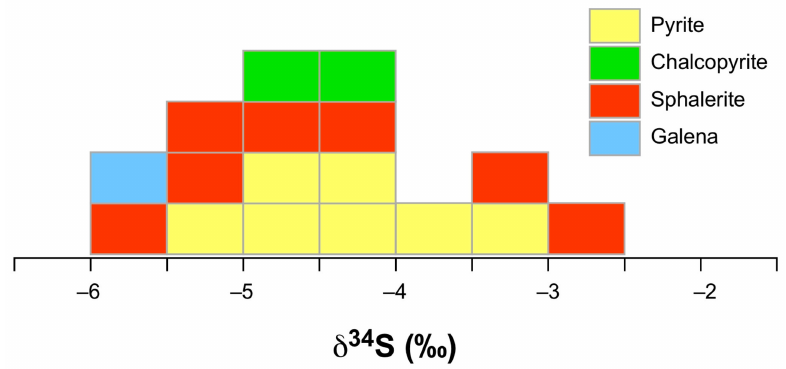
Figure 12. Histogram of the isotopic composition of sulphur in sulphides of the Poop ó deposit, Bolivia. See data in Table